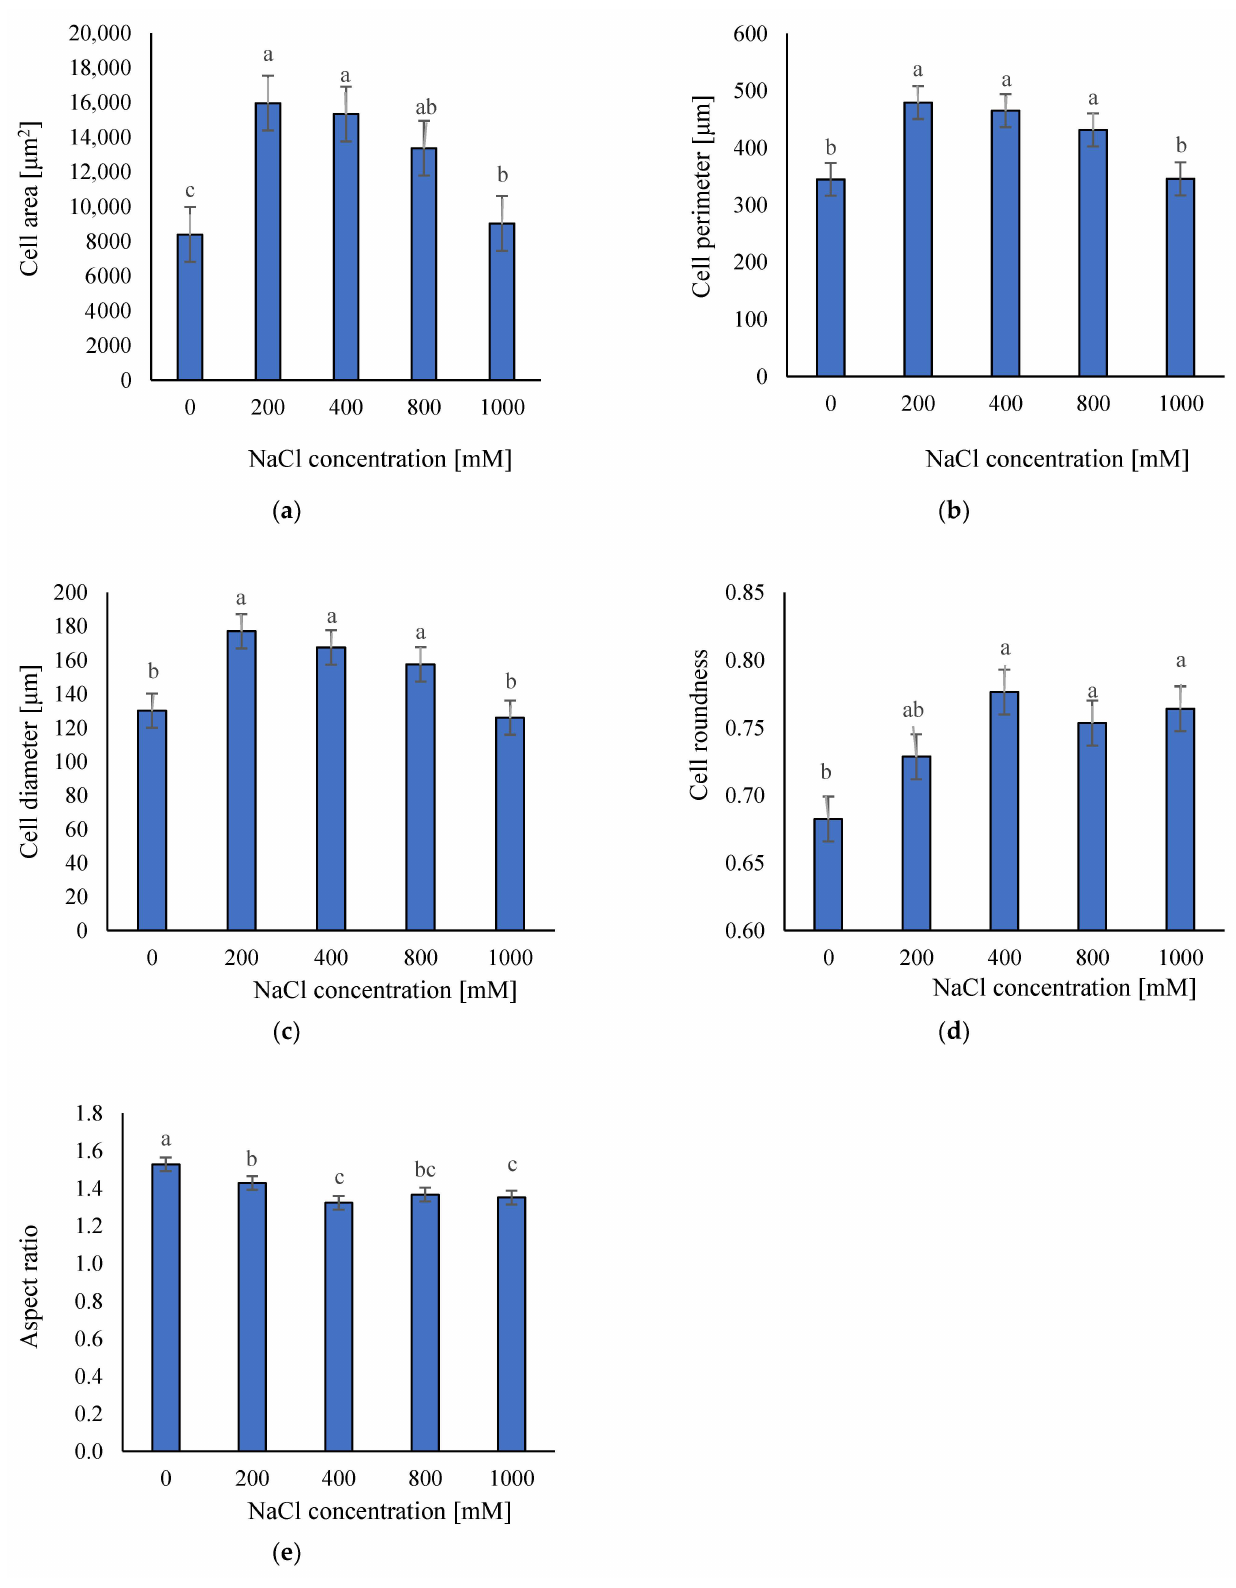
Figure 5. The average parameters of: ( a ) area; ( b ) perimeter; ( c ) diameter; ( d ) roundness; ( e ) aspect ratio of the Salicornia europaea L. cells; ± SD in the tested samples. ANOVA p < 0.001, significant differences based on post hoc Tukey’s test are marked with different